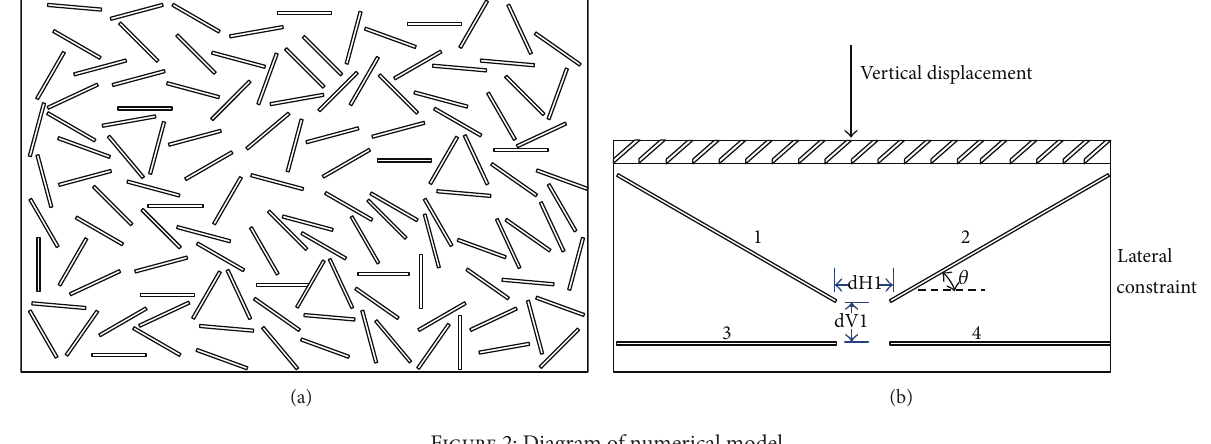
Figure 2: Diagram of numerical